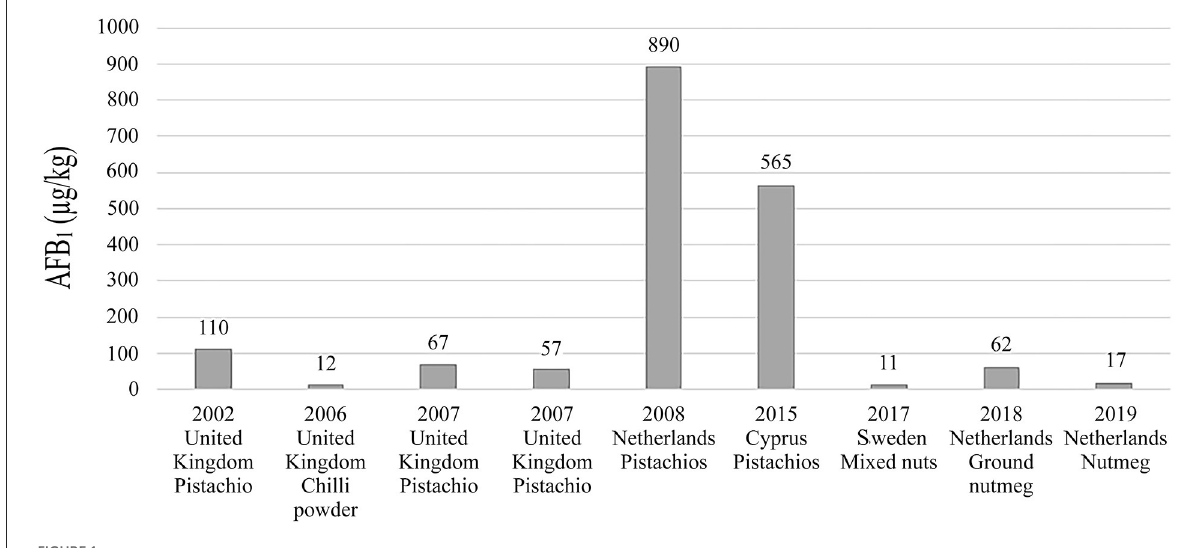
FIGURE1 Examples of reported border rejections on RASFF portal of Lebanese imports to the European Union due to high levels of AFB 1 in spices, herbs, and